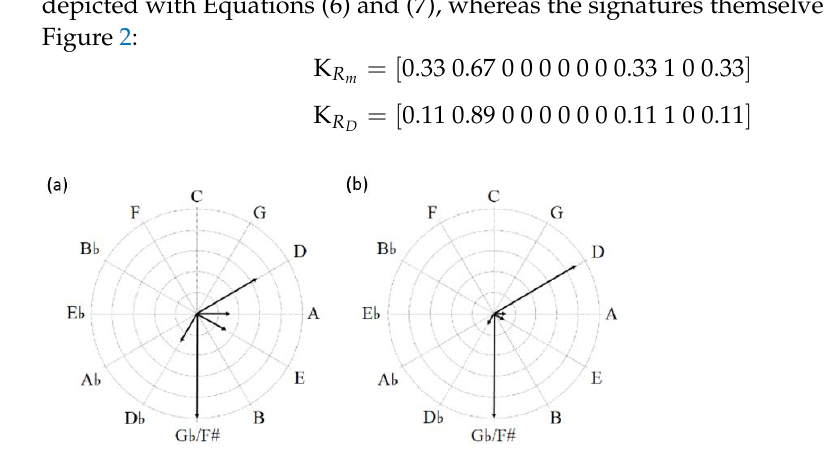
Figure 2. The analyzed fragment of a sample music piece. The signatures of fifths representing the fragment of the music piece shown in Figure 1: ( a ) obtained for the multiplicities of occurrences of individual pitch-classes; ( b ) obtained for the aggregate durations of individual pitch-classes.